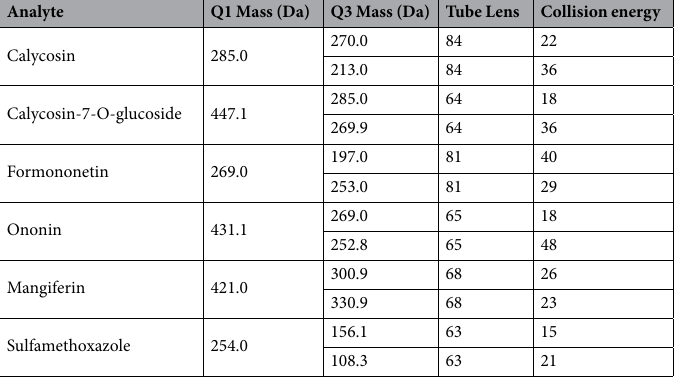
Table 1. The main quantitative parameters of MRM for calycosin, calycosin-7-O-glucoside, formononetin, ononin and mangiferin.